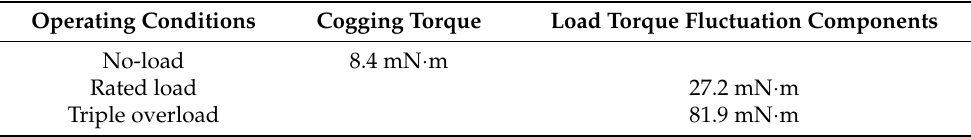
Table 5. Cogging torque and load torque fluctuation